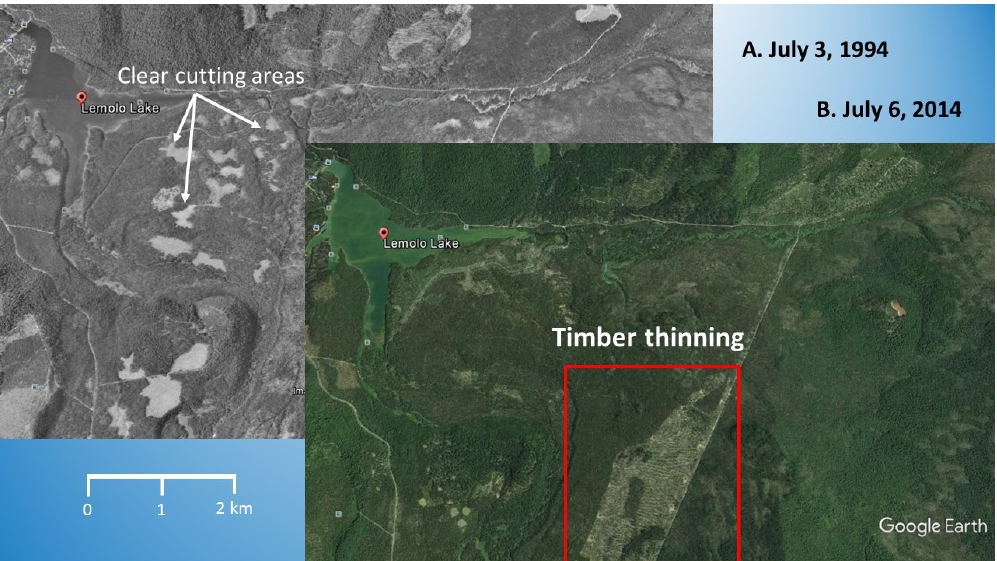
Figure 3. United States Department of Agriculture (USDA) black and white, and color aerial images, of the Lemolo Lake area, Oregon. Images were taken: ( A ) 3 July 1994 (black and white), and ( B ) 6 July 2014 (color). Bright patches in image A indicate areas of clear cutting. The red boundary in image B is an area currently being thinned. Source: Images obtained from Google Earth.